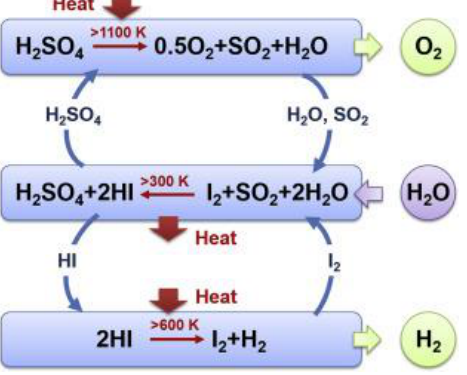
Figure 26. Schematic of the iodine – sulfur thermochemical water-splitting cycle. Reprinted from [117] with permission from Elsevier.